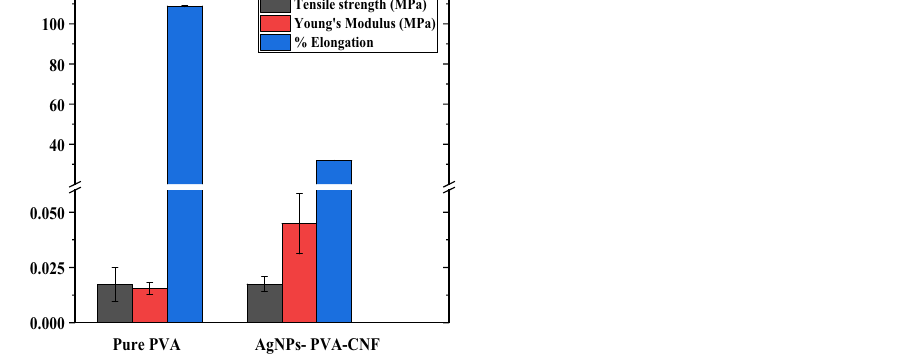
Figure 5. Comparison of the mechanical properties of the pure PVA and AgNPs@PVA-CNF composite films.